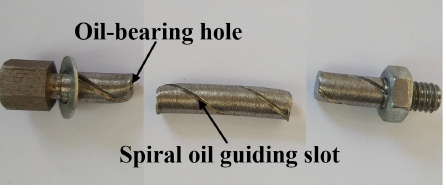
Figure 15. Destroyed bolt in the experiment.